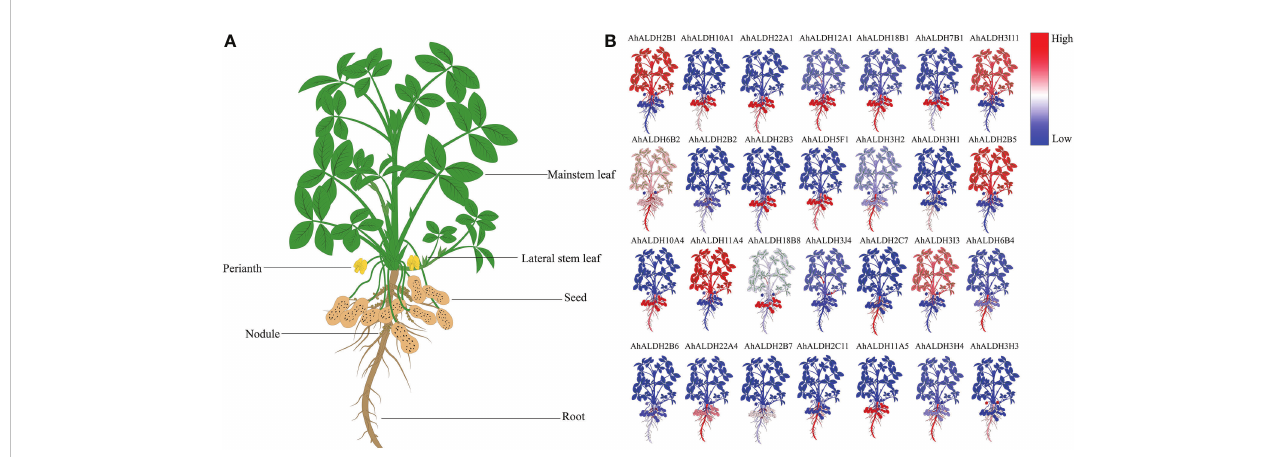
FIGURE 8 Expression pattern analysis of AhALDH s in different tissues. (A) Schematic diagram of different groundnut tissues; plants were divided into root, nodule, seed, perianth, and leaf. (B) Expression levels of AhALDH s. A change in color from blue to red represents ALDH levels from low to